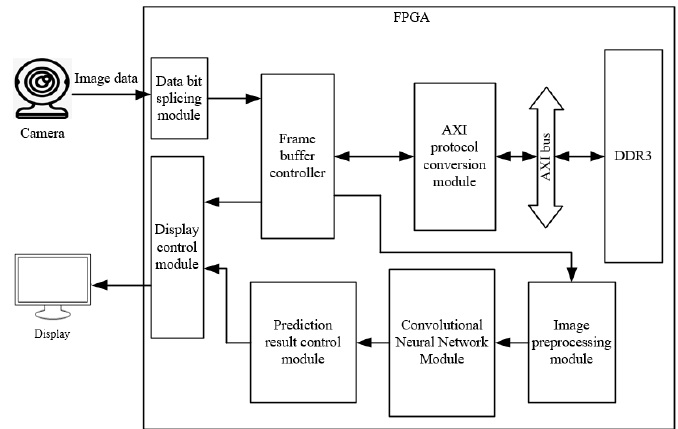
Figure 2. Overall block diagram of the